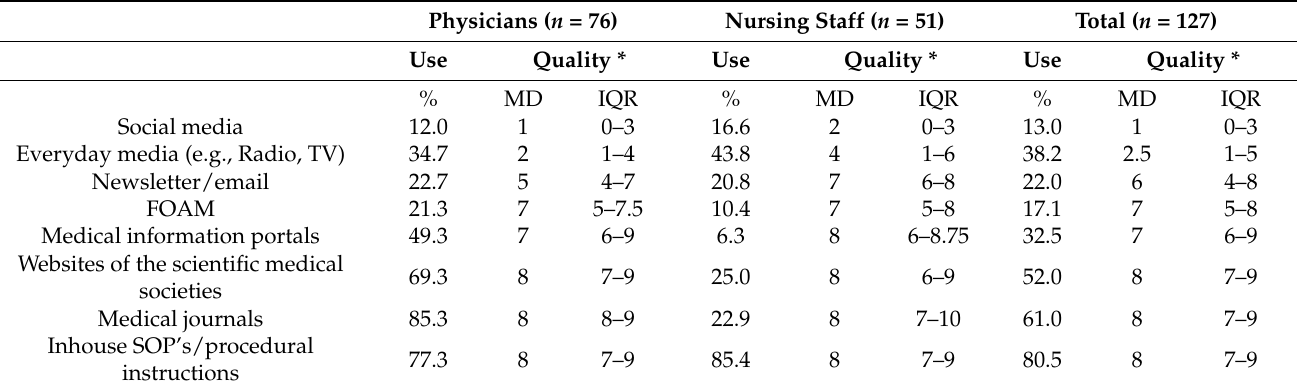
Table 1. Media sources used by participants, summed up free text answers .